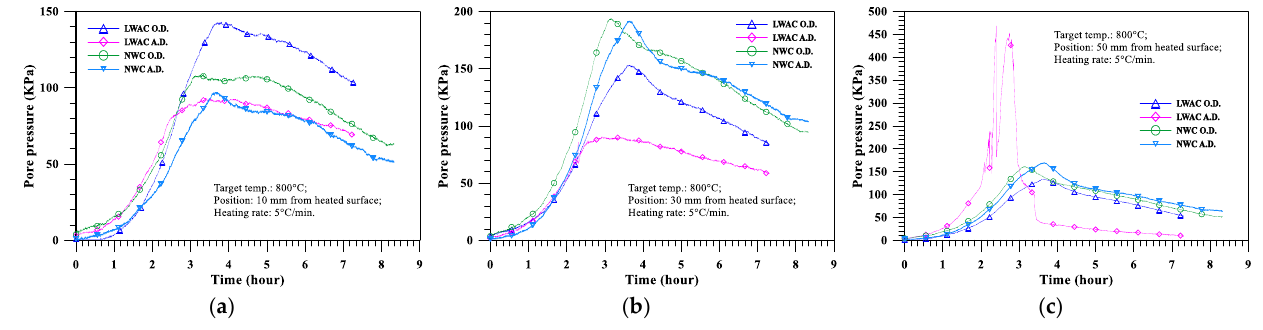
Figure 26. Effect of the moisture content on the pore pressure of the specimens performed at a target temperature of 800 °C and a heating rate of 5 °C/min: ( a ) 10; ( b ) 30; ( c ) 50 mm depths.